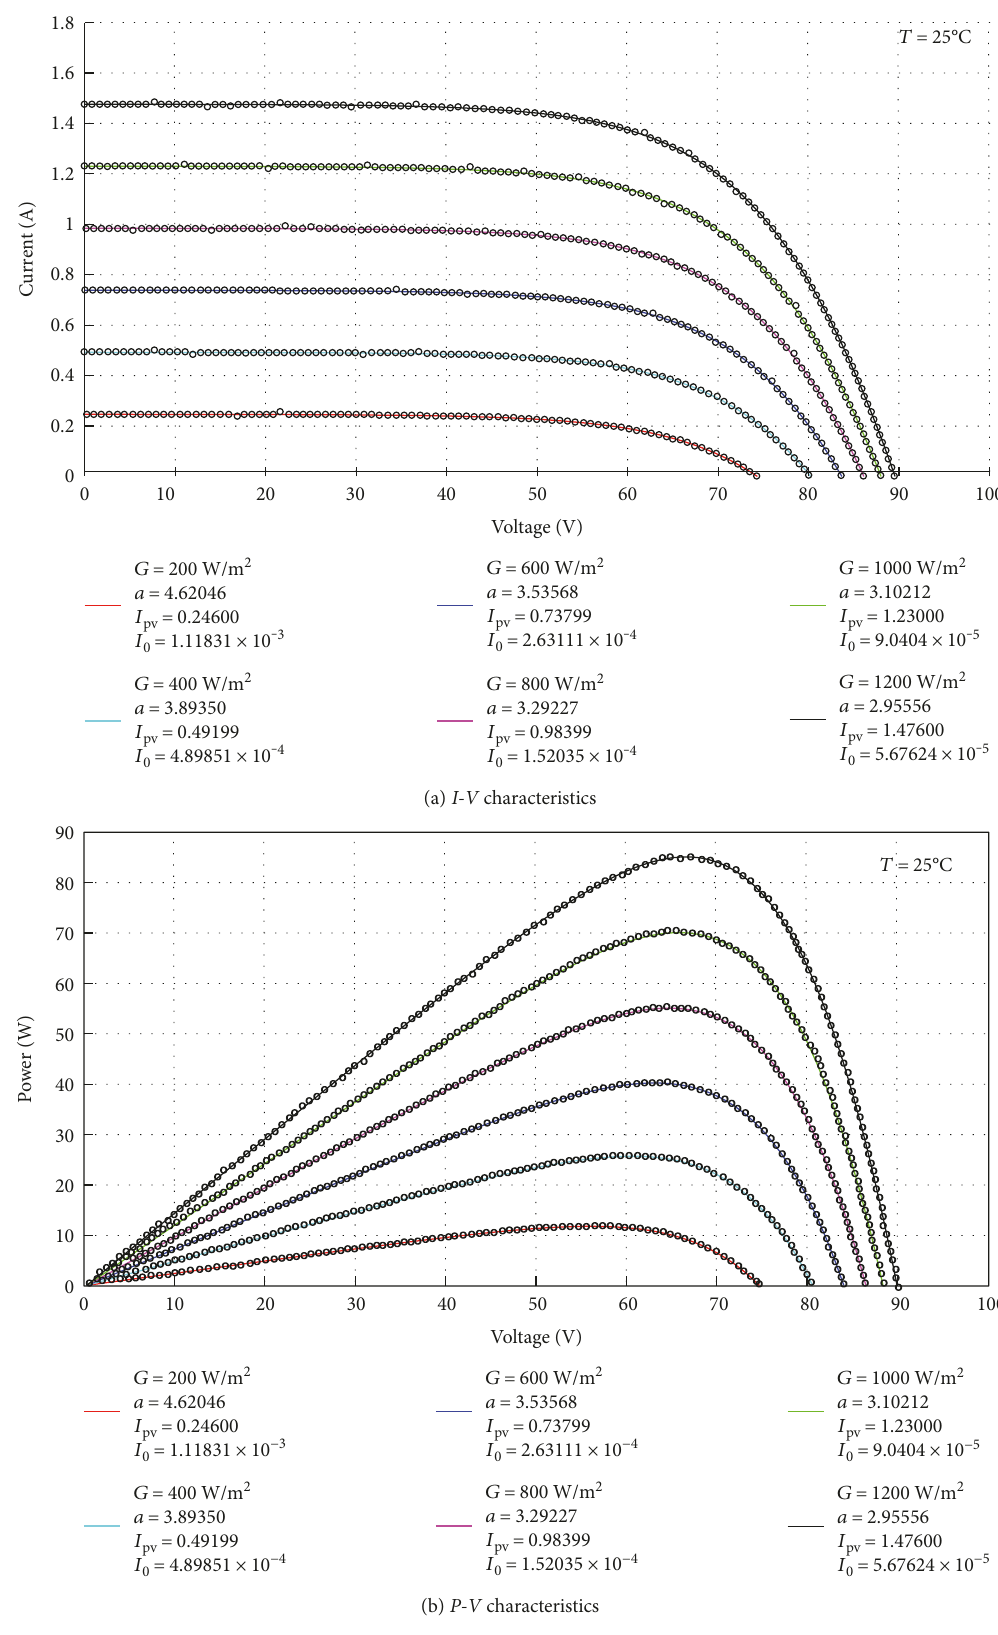
Figure 5: Characteristics and experimental data of the FS-270 PV module at di ff erent irradiances (temperature constant=25 °